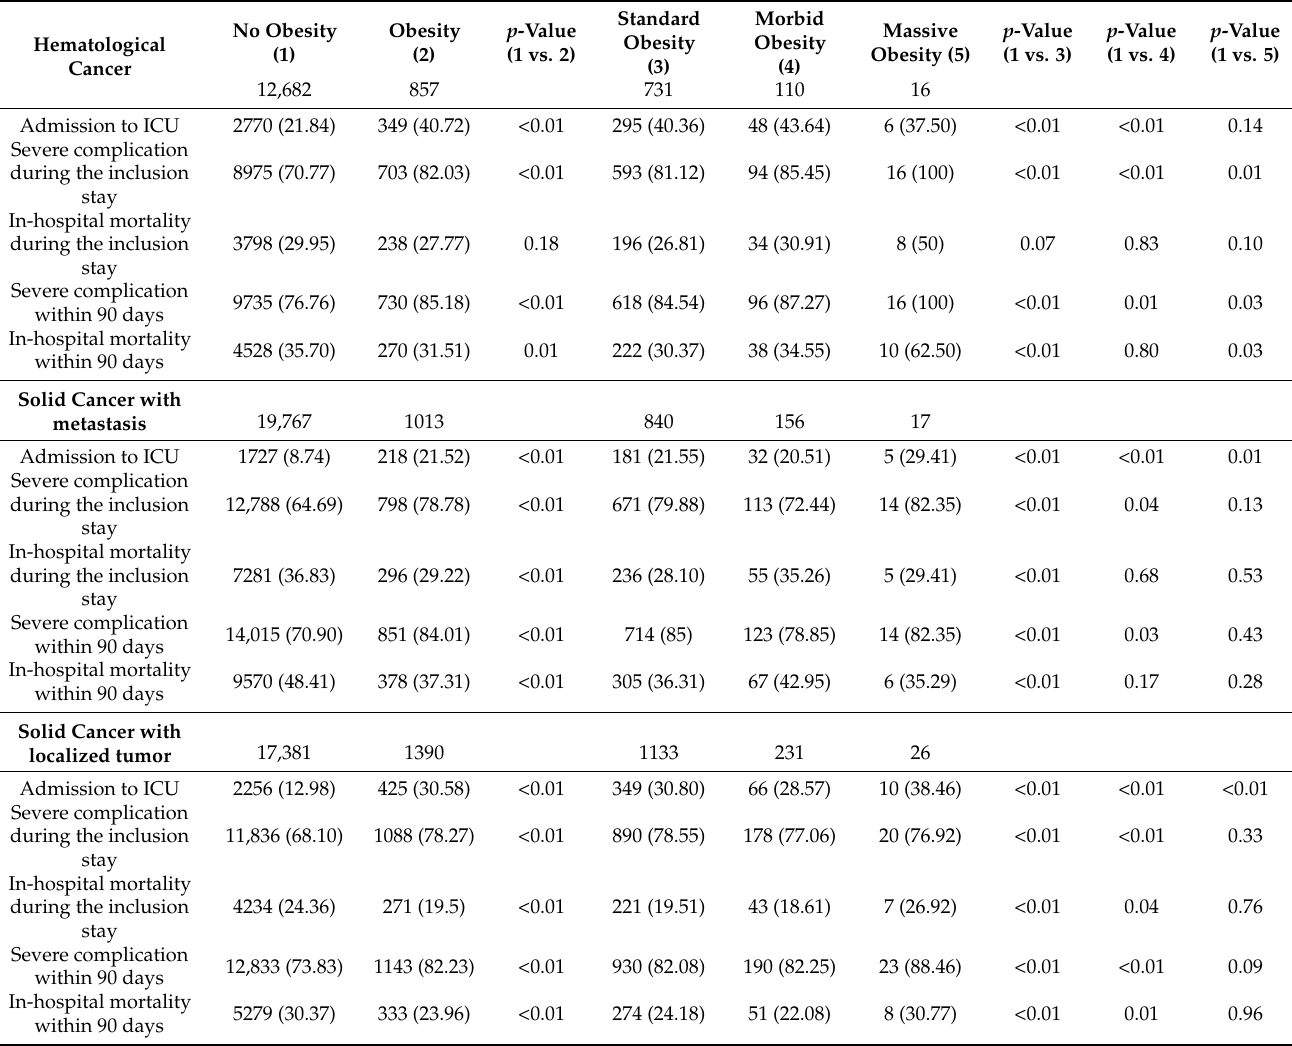
Table 3. Admission to ICU, severe complication and in-hospital mortality of COVID-19 cancer patients by type of cancer and